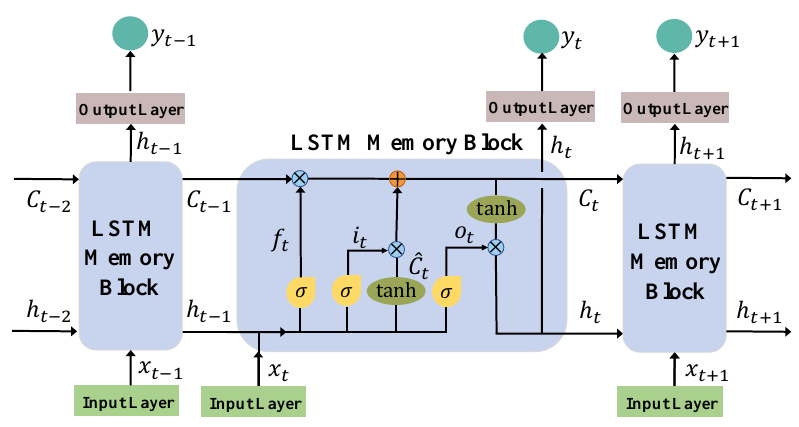
Figure 2. The structure of LSTM memory block.